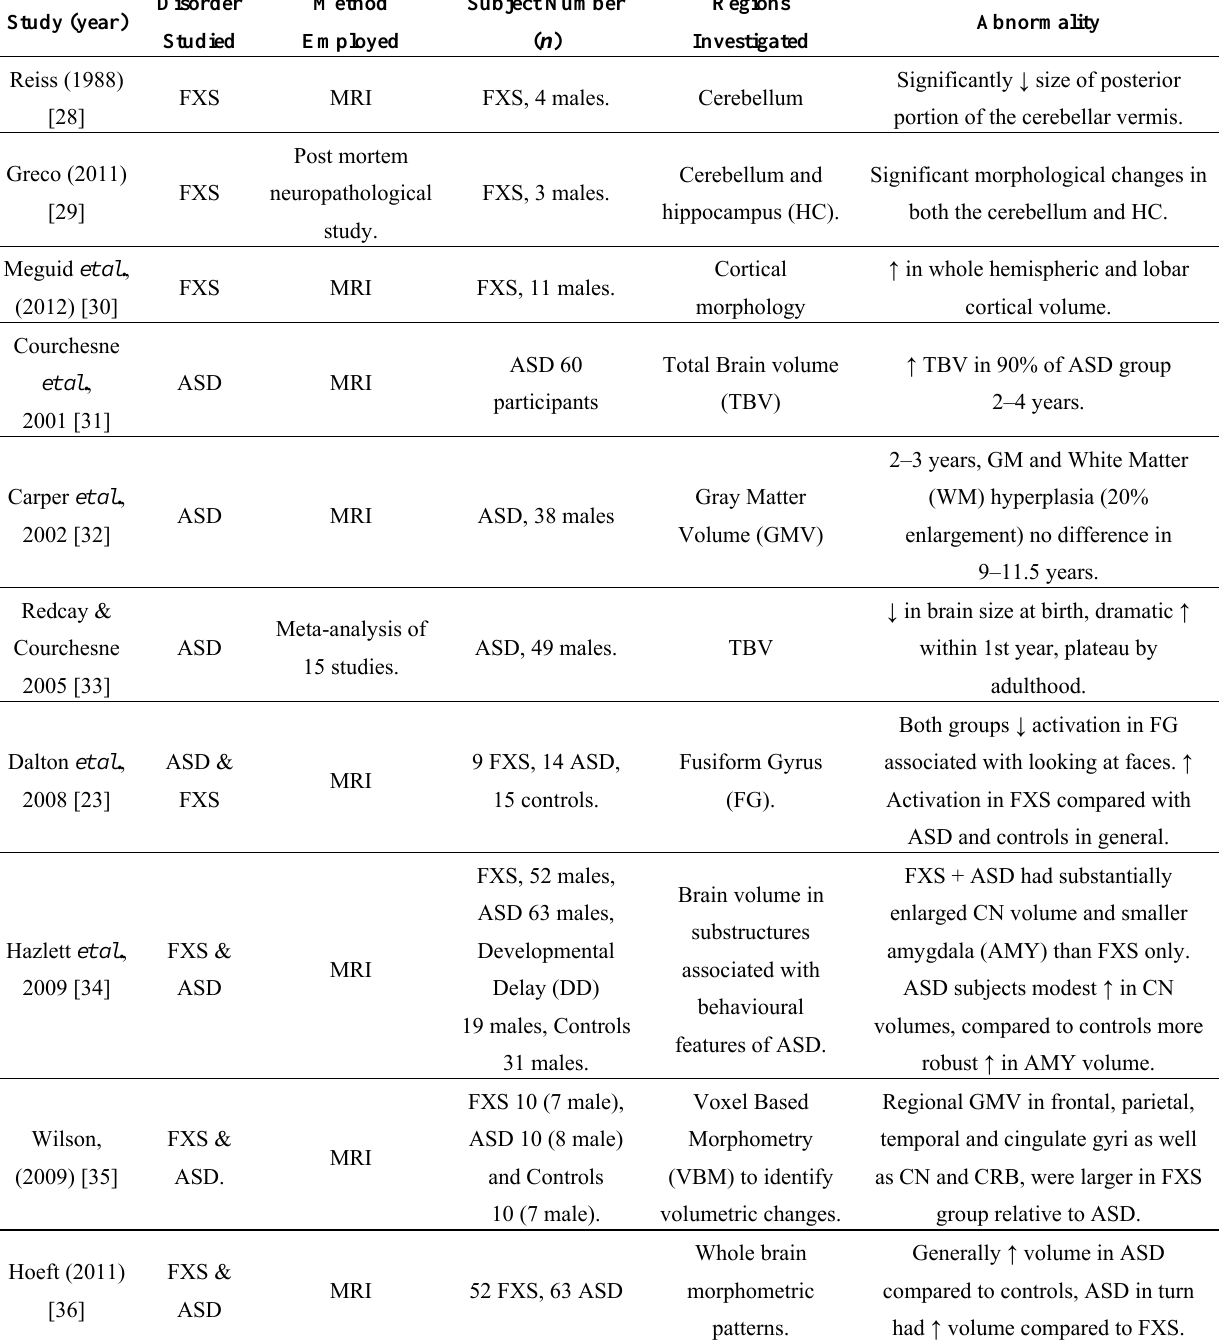
Table 1. A comparison of Fragile X Syndrome (FXS) and Autism Spectrum Disorder (ASD) through neuroanatomy and neuroimaging